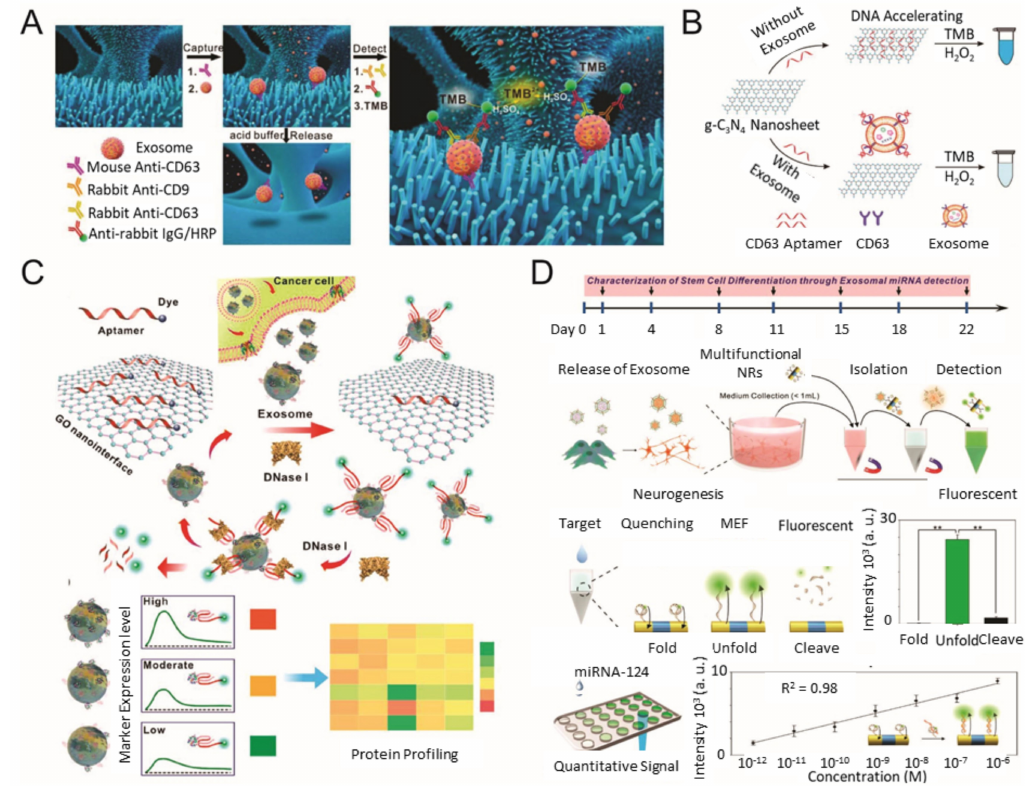
Figure 2. Colorimetric / fluorescence biosensor for EV detection. ( A ) Schematic diagram of the ZnO-nanowires-coated three-dimensional (3D) sca ff old chip for EV detection; ( B ) utilization of peroxidase-like activity of graphitic carbon nitride nanosheets (g-C3N4 NSs); ( C ) fluorescence resonance energy transfer (FRET) biosensing system based on aptamer and graphene oxide (GO); ( D ) multifunctional nanorods (NRs) based exosomal miRNA signal amplification based on metal-enhanced fluorescence e ff ect. (reproduced with permission from [52] published by Elsevier 2018, reproduced with permission from [54] published by American Chemical Society 2017, reproduced with permission from [55] published by American Chemical Society 2018 and reproduced with permission from [63] published by American Chemical Society